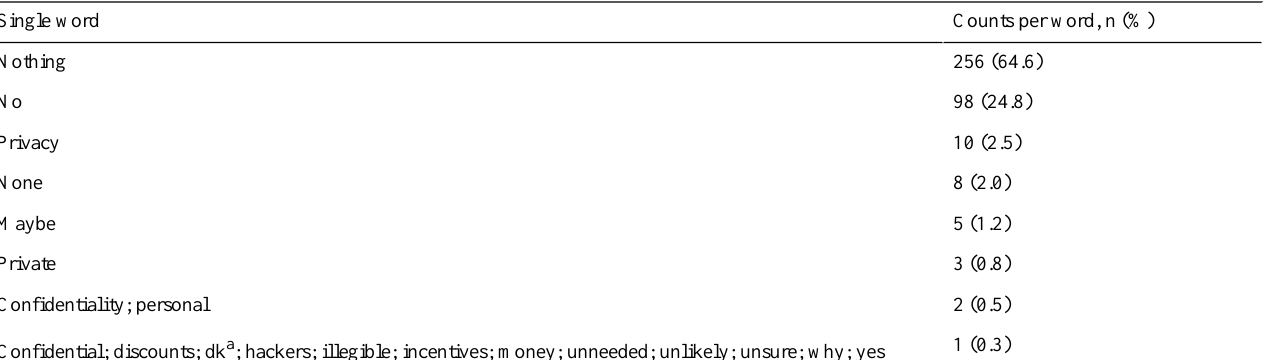
Table 1. Counts of single-word responses to the question, “What (if anything) might make you change your mind in the future?” about sharing store loyalty card data for linkage with health records